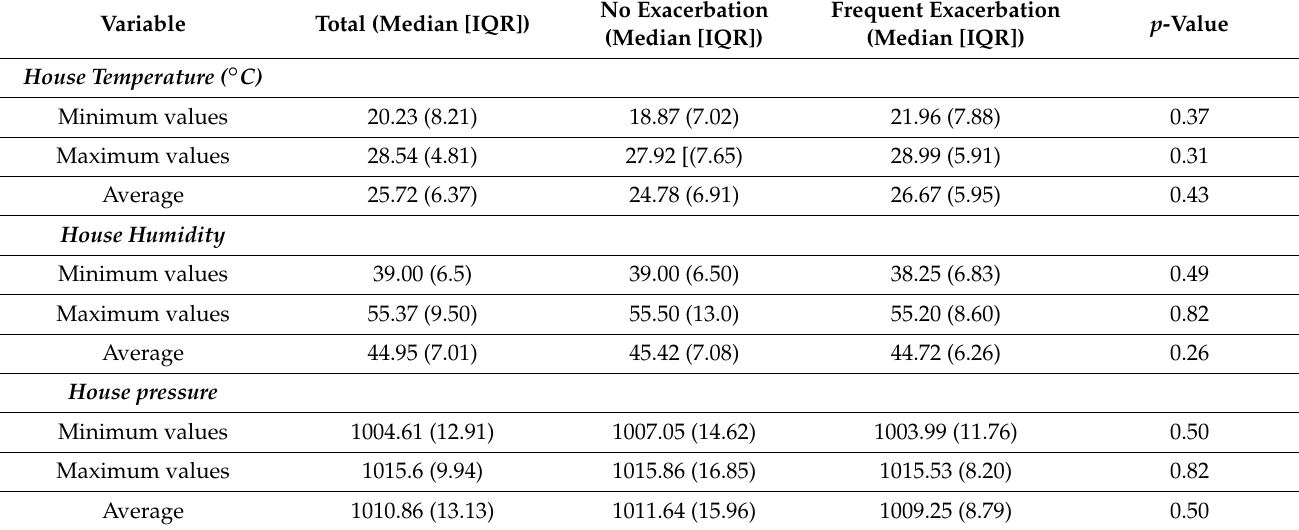
Table 2. Atmospheric parameters in the home settings of 79 COPD